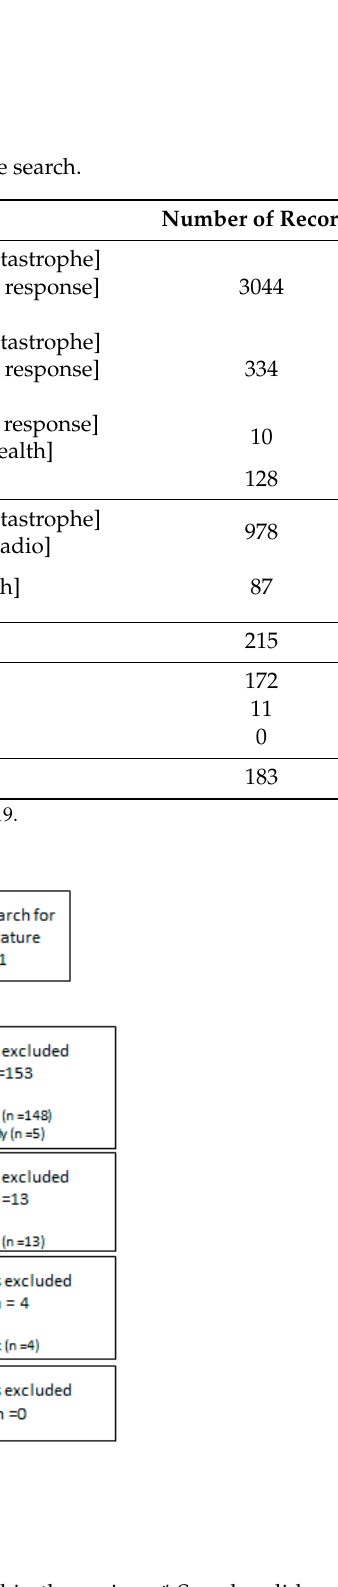
Figure 1. Overview of the process to identify papers included in the review. * Search valid as of 4 March